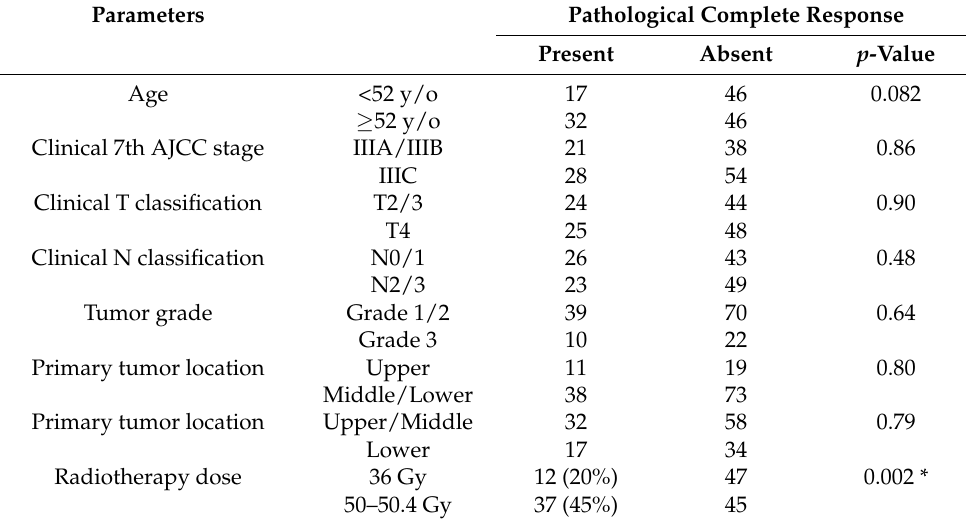
Table 3. Associations between pathological complete response and clinicopathologic parameters